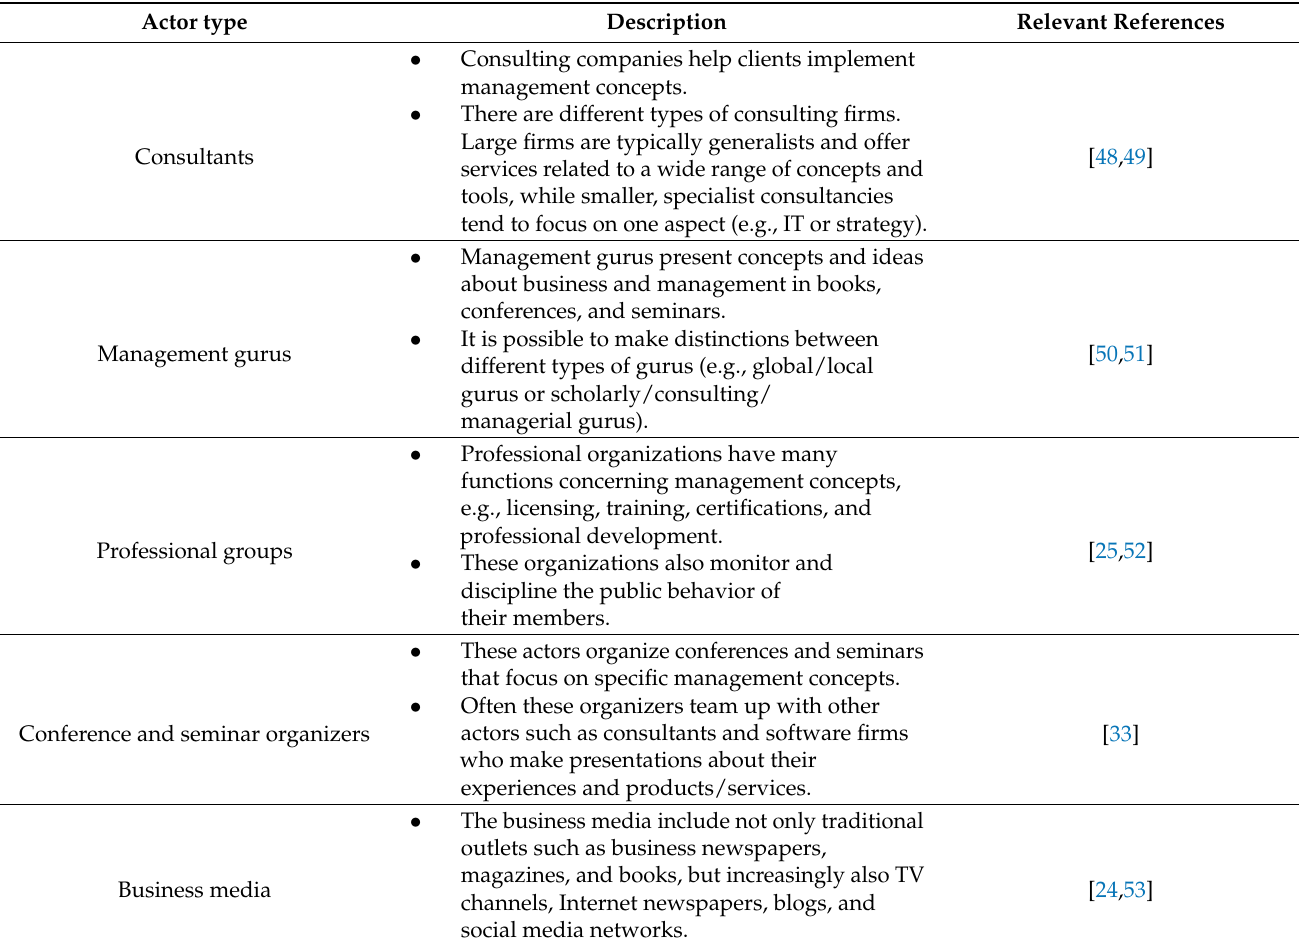
Table 1. The main actors involved in the management fashion